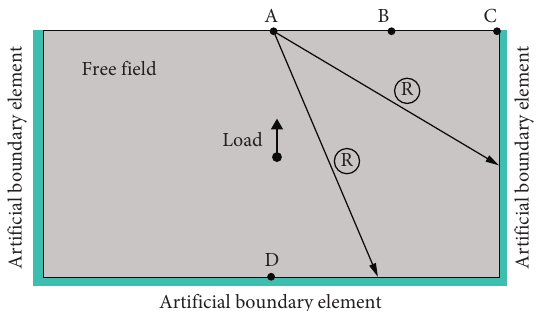
Figure 7: Two-dimensional homogeneous elastic half-space